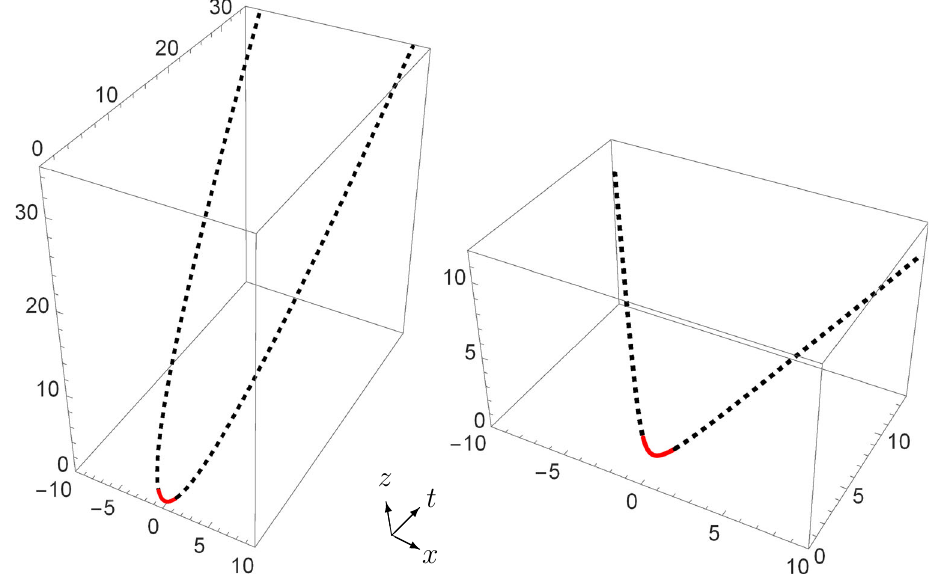
is a global circle that partly lies behind the Poincaré horizon. For both curves the bottom segment, shown in solid red, is reconstructible with tangent vector alignment, but the sides, shown in dashed black, violate condition (84) and require null vector alignment to be